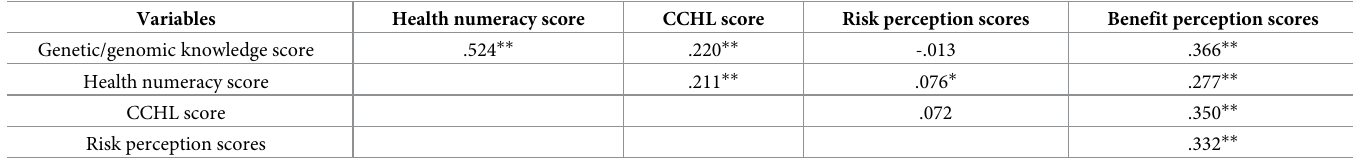
Table 3. Correlation analysis among three components of genomic literacy in 20s and